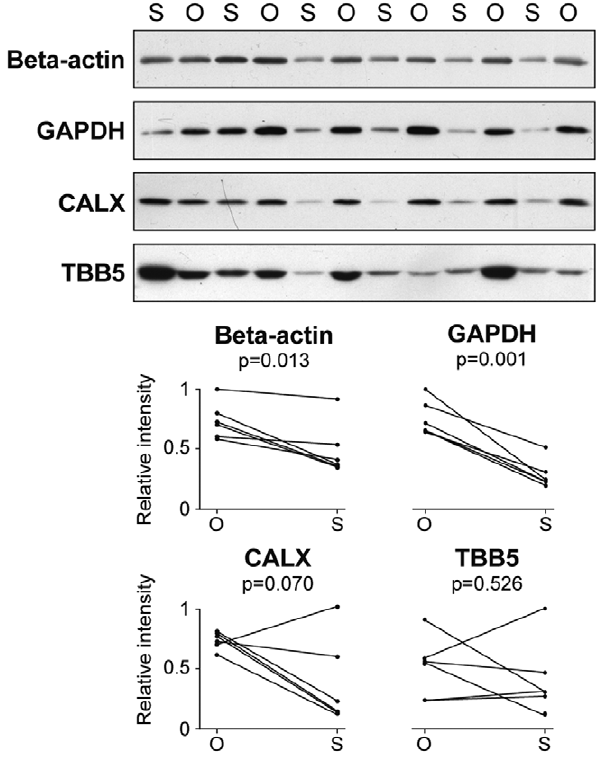
Figure 1. Protein expression levels in human omental and subcutaneous adipose tissue. Representative Western Blot analysis of Beta-actin, GAPDH, CALX and TBB5 in omental (O) and subcutaneous (S) fat samples. Paired relative intensity values from band densitometry in omental and subcutaneous fat samples from the same individual are